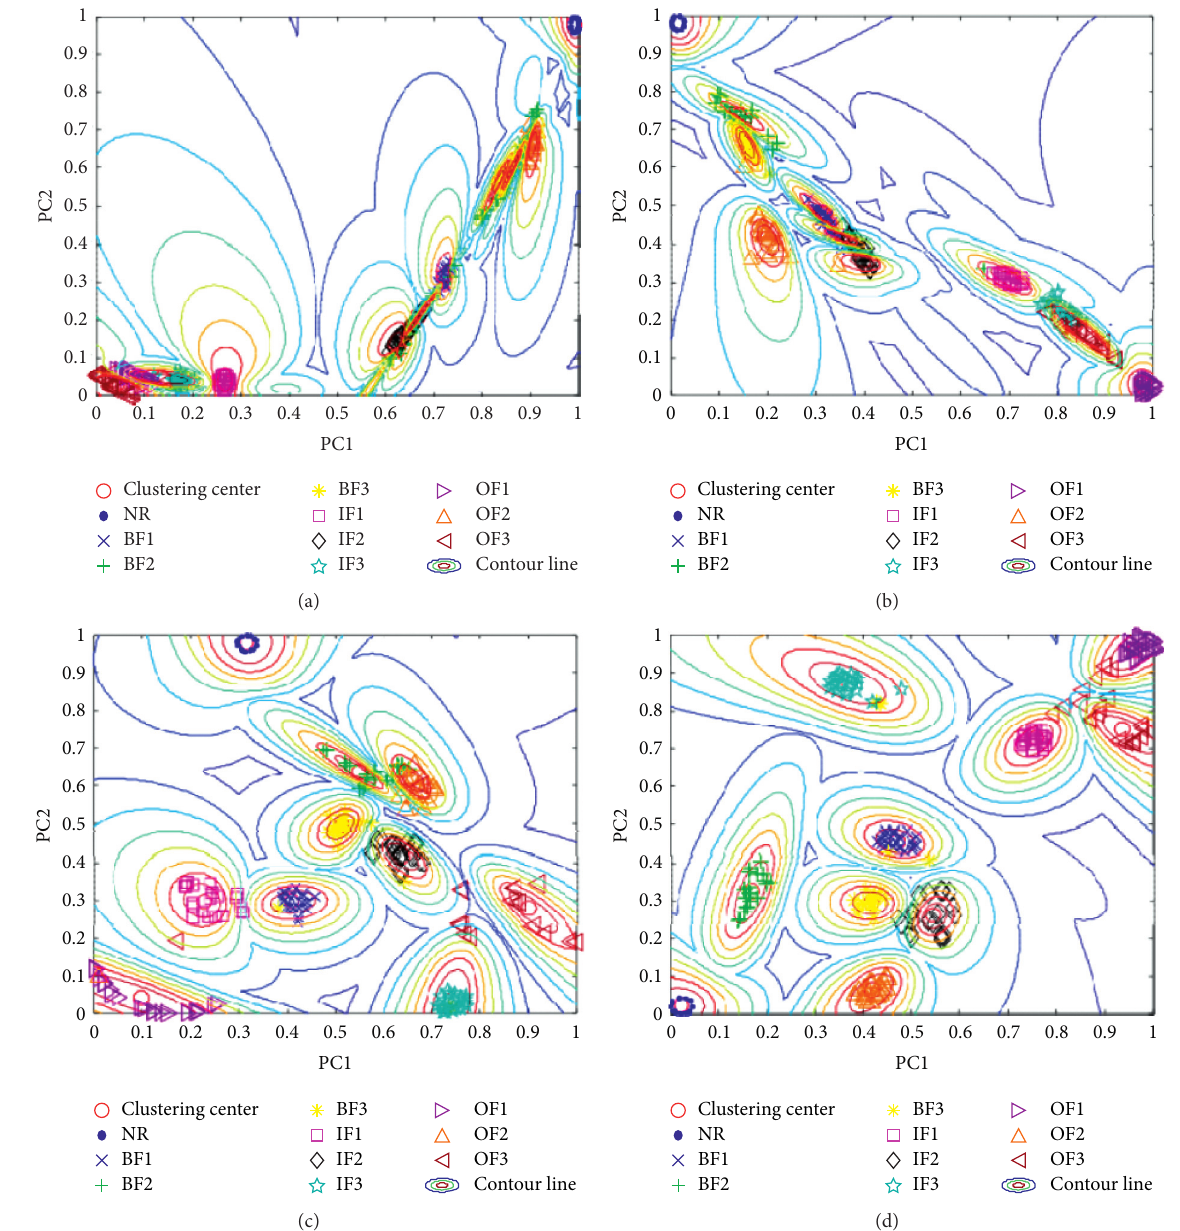
Figure 11: The results of the contrast tests. (a) EMD+FE +AWN-GK; (b) Multifractal+ANW-GK; (c) SDAE +AWN-GK; (d)